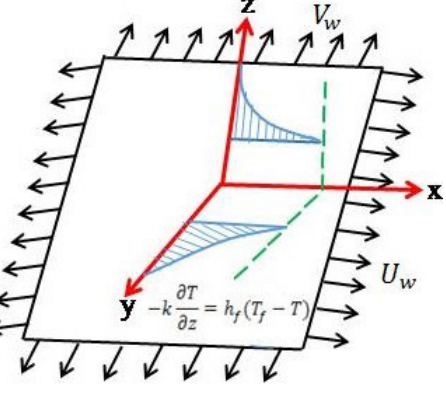
Fig. 1: A schematic flow